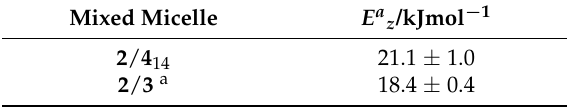
Table 2. The effective activation energy of the rotation diffusion of 4 14 in 2 / 4 14 and 3 in 2 / 3 . Mixed